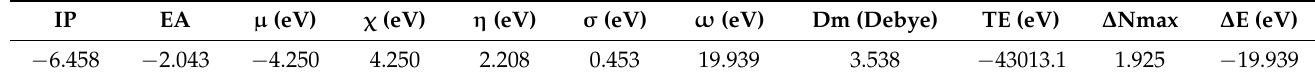
Table 2. The DFT calculated global reactivity and energetic parameters for compound 10